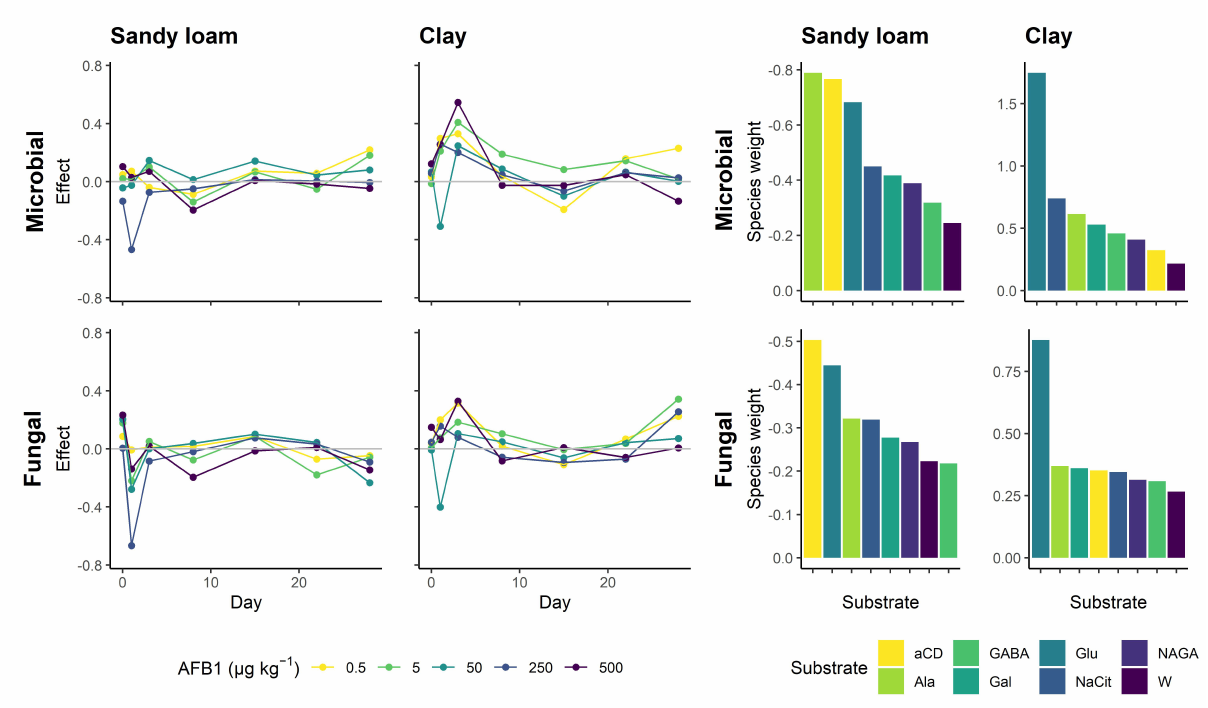
Figure 4. Microbial and fungal carbon source utilization patterns. Left panel: Principal response curves showing the temporal multivariate catabolic response for each AFB1 concentration level as deviations from the nonspiked control (i.e., the zero line). Right panel: Barplots showing the species weights (right) for the response of individual substrates. Glu = D-glucose, Gal = D-galactose, GABA = γ -aminobutyric acid, NAGA = N-acetylglucosamine, NaCit = sodium citrate, and aCD = α